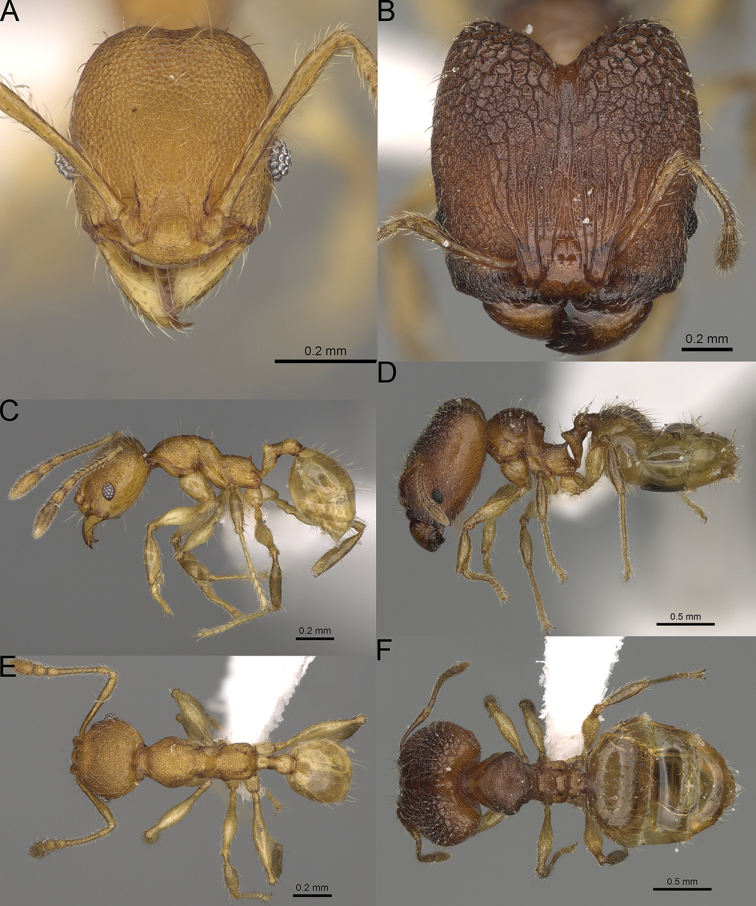
Pheidole
ala sp. nov., full-face view (A), profile (C), and dorsal view (E) of paratype minor worker (CASENT0427742) and full-face view (B), profile (D), and dorsal view (F) of holotype major worker (CASENT0413606).